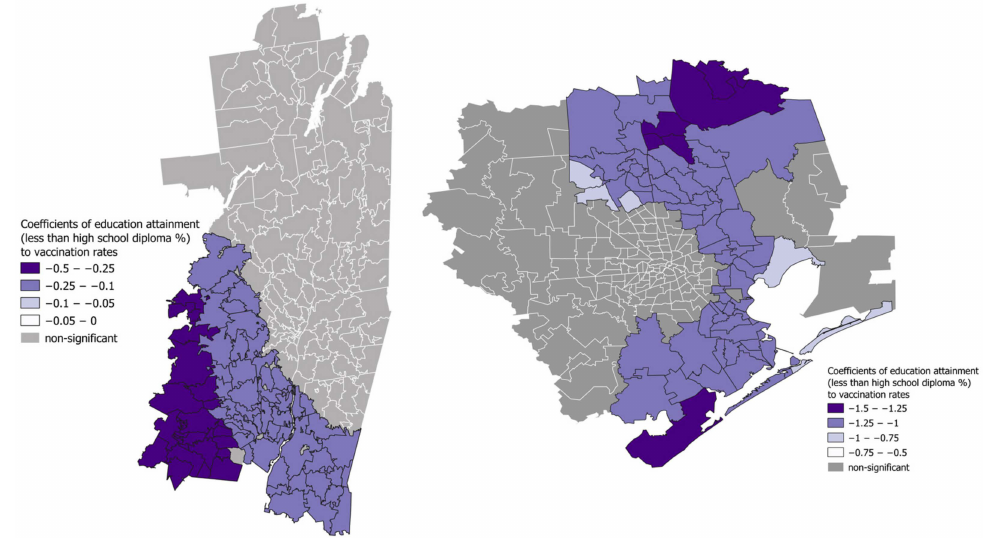
Figure 5. Local coefficients of educational attainment (less than a high school diploma %) with regard to vaccination rates as obtained using geographically weighted regression (GWR).